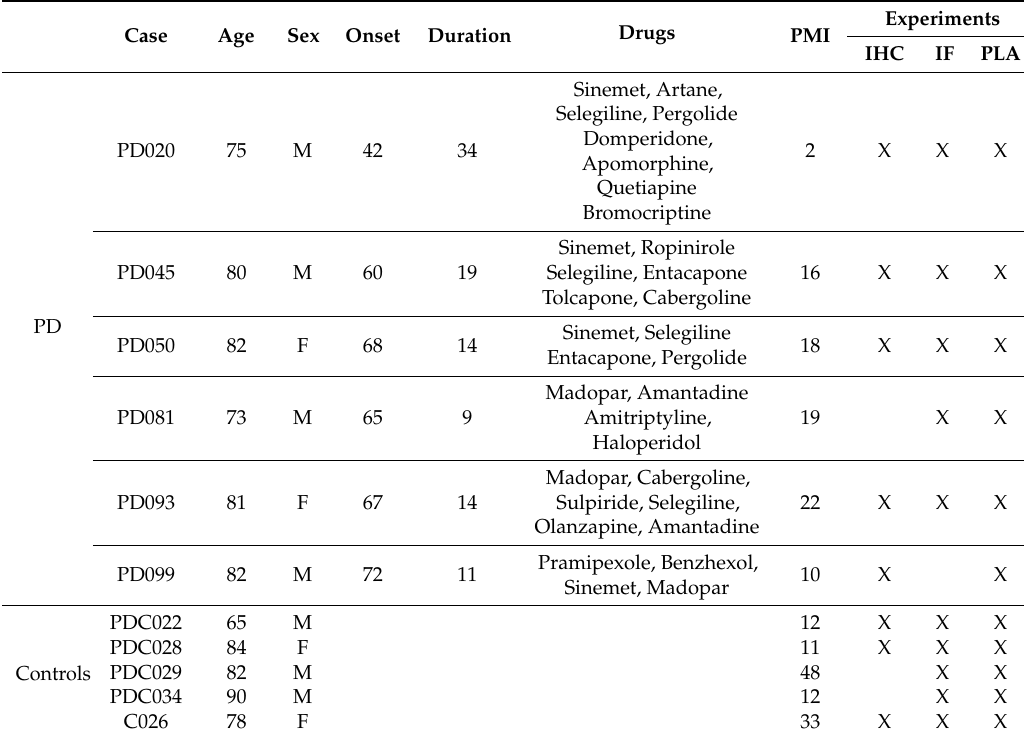
Table 1. List of patients affected by PD and the control subjects used for the experiments. Each X indicates the samples used for the different immune-based